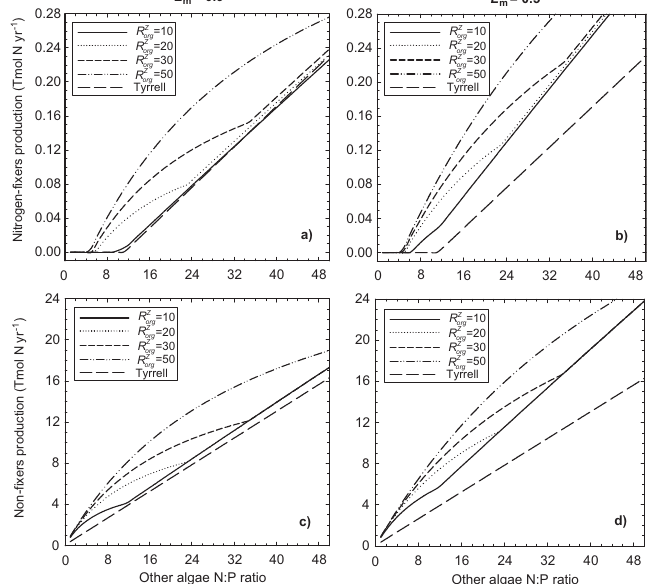
Fig. 5. (a) and (b) N 2 -fixation plotted against the ratio of nitrogen to phosphorus (N:P) in non-fixers using two different maximum accu- mulation efficiencies for herbivores ( L m =0.9 or L m =0.5), and four different N:P ratios in herbivores ( R Z org ). The assimilation efficiency of ) and phosphorus ( β P nitrogen ( β N ) were set at 0.69 and 0.80, respectively. (c) and (d) same as (a) and (b), but for non-fixers. Solutions for 1 1 the Tyrell’s model without herbivores are also shown (dashed line).